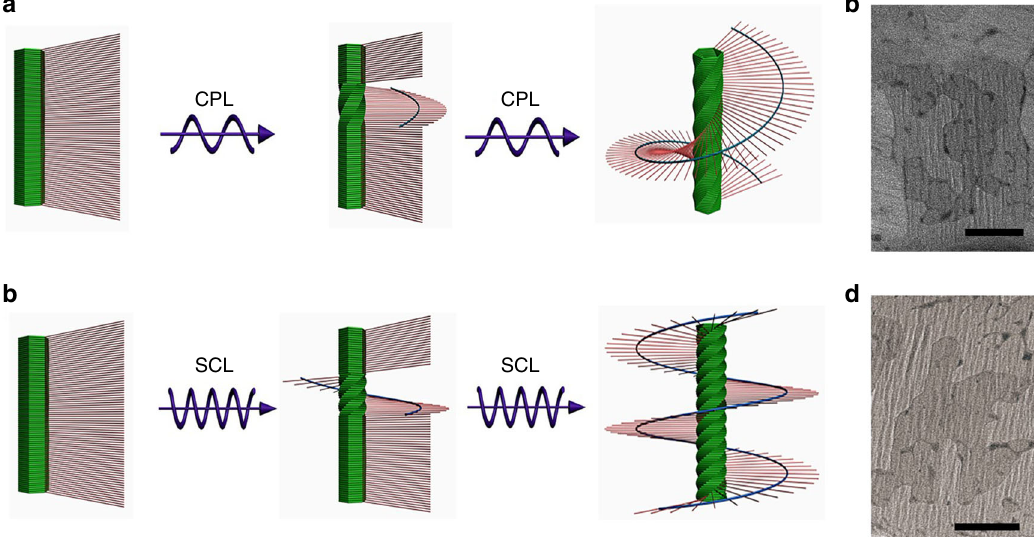
Fig. 2 Possible helix formation mechanism and TEM characterization. Scheme for asymmetric photo-polymerization mechanism for helical PDA chains prepared by application of a CPL and c SCL irradiation. TEM imagines of helical PDA chains prepared with b CPL and d SCL. TEM imagines revealed that more helical PDA chains were formed by application of SCL than polymerized with CPL. The arrows in a and c represented CPL and SCL, respectively. Scale bars, 200 nm